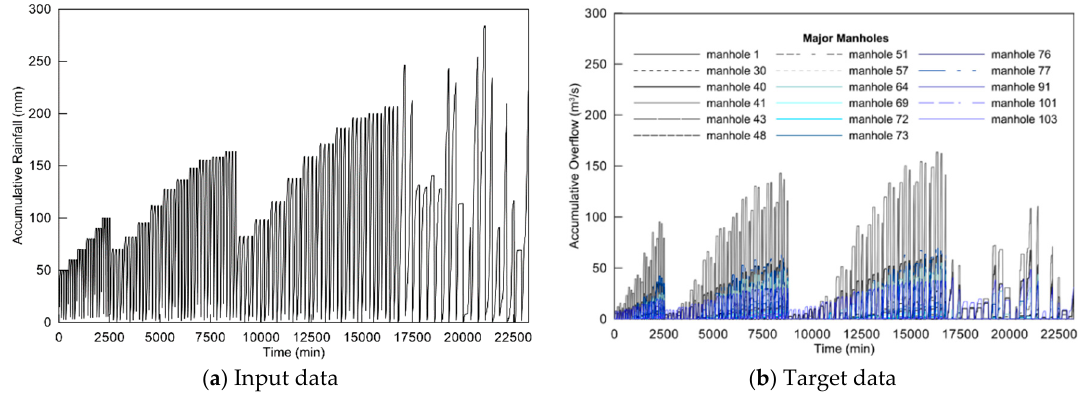
Figure 7. Training data for the prediction model.